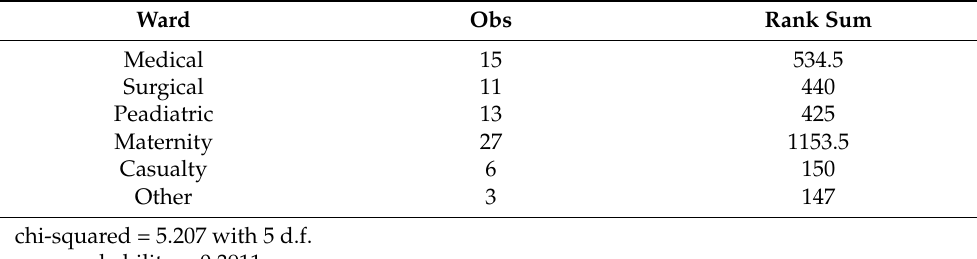
Table A2. The relationship between hand hygiene adherence and the ward unit in which the study participants worked.